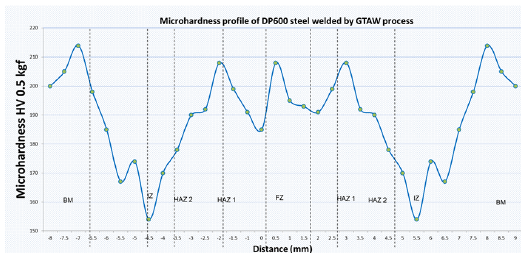
Figure 5. Exhibited microhardness profiles in the various regions of the welded DP600 steel using GTAW process. AFM images enabled the identification of M, TM and PF in the base metal and intercritical zone. In turn, quantitative determinations of the relative amounts of these phases were possible. The AFM offers substantial benefits in comparison with the others microcopy techniques, namely quantitative data acquisition in three dimensions, minimal sample preparation times, and effective magnifications, also its ability to evaluate quantitatively select surface features. The topographic study of the DP600 steel samples showed that the higher areas in the samples correspond to the martensitic phases and the lower areas correspond to ferrite. SEM images were also used to confirm the amounts of martensite in the BM compare with the tempered martensite development in the IZ. The microhardness profiles confirm IZ softening exists during welding of tempered DP600 steel with hardness near to 155 HV0.5 compare to 215 HV0.5 in BM. AFM was used with scan heads of nominally 50×50 μm 2 scanning IZ and BM areas; and the phases quantifications obtained by SEM images were carry out with an area of 85×62 μm 2 . In the case of TM the vol. % present in the IZ obtained by OM and SEM showed that the average of TM was of 11.91 % compare with 5.25 % obtained by AFM. This result is attributed to the selected examination locations. Nevertheless, when selecting the same scanning areas, the obtained results will be without